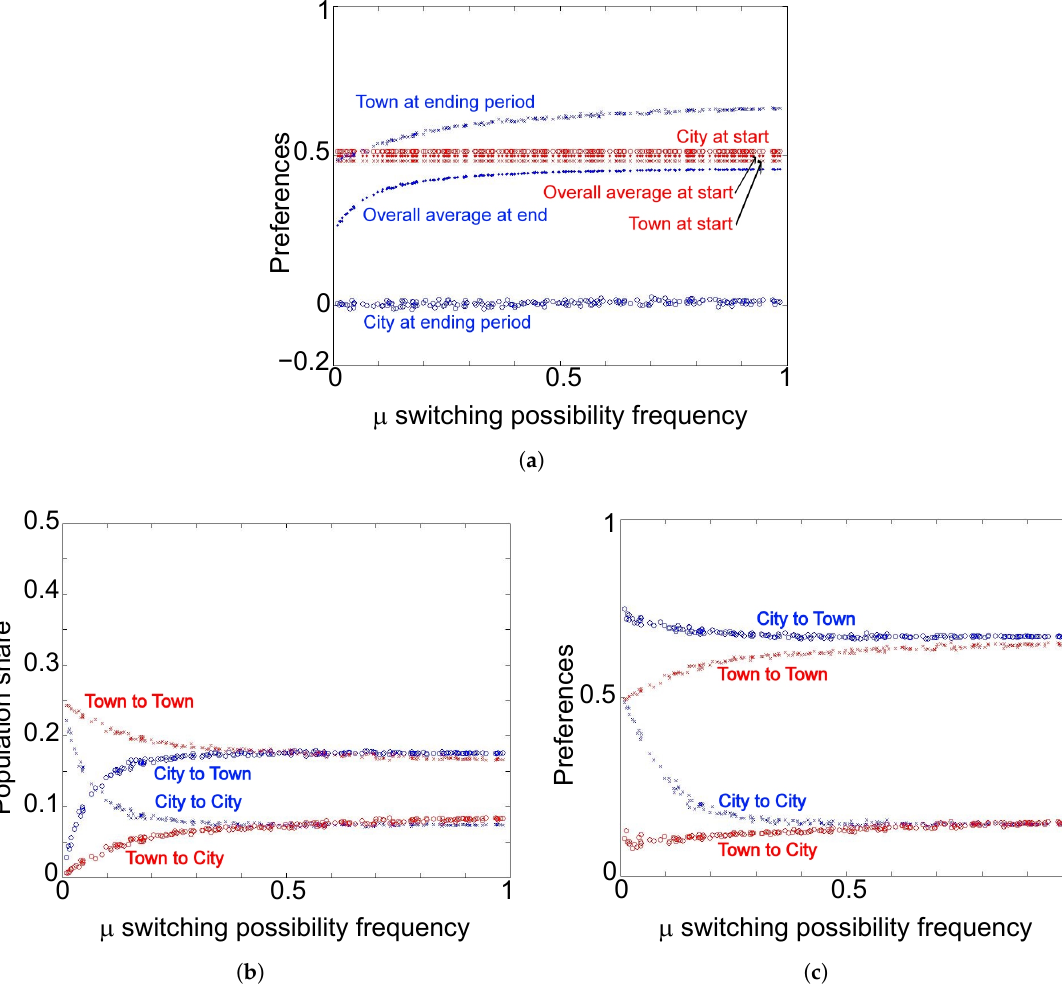
Figure 3. The Monte Carlo simulation with switching opportunity frequency µ ∈ ( 0,1 ) . ( a ) average preferences of ethnicity ⊕ ; ( b ) sizes of flows of ethnicity ⊕ ; ( c ) initial average preferences of ethnicity ⊕ by the initial community and the ending community. In ( a ), × represents the town, · overall average and ◦ the city, while blue markers show average preferences at the ending period and red markers show those at the beginning period. In ( b , c ), red markers show agents who start initially from the town and blue markers those initially from the city, while × represents ending at the town and ◦ ending at the